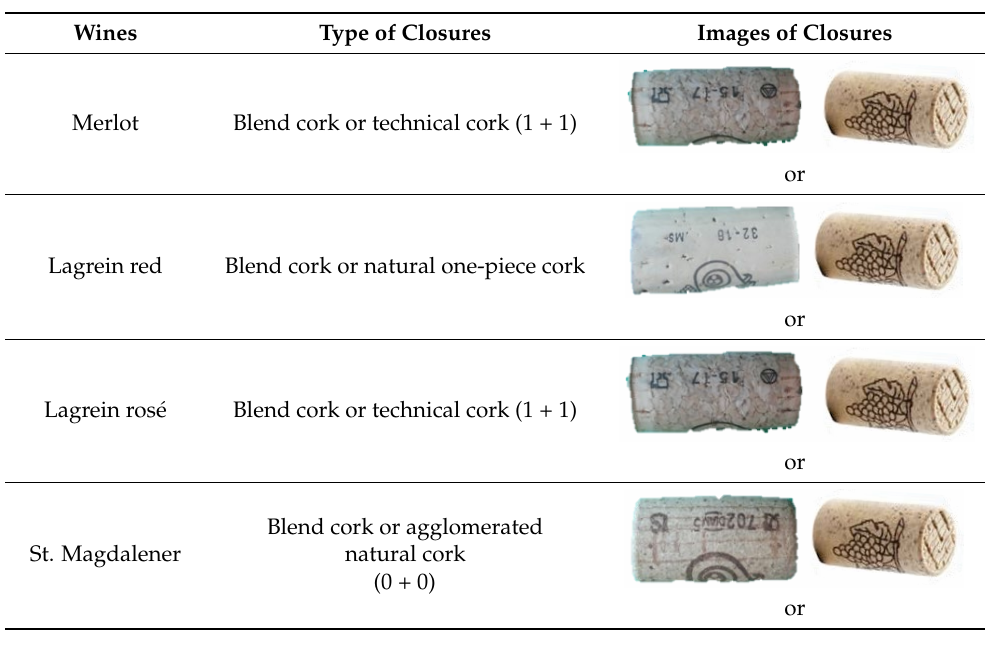
Table 1. The three different ‘conventional’ closures used to close the wine bottles which were compared with a control closure (‘blend’ cork). Wines Type of Closures Images of Closures